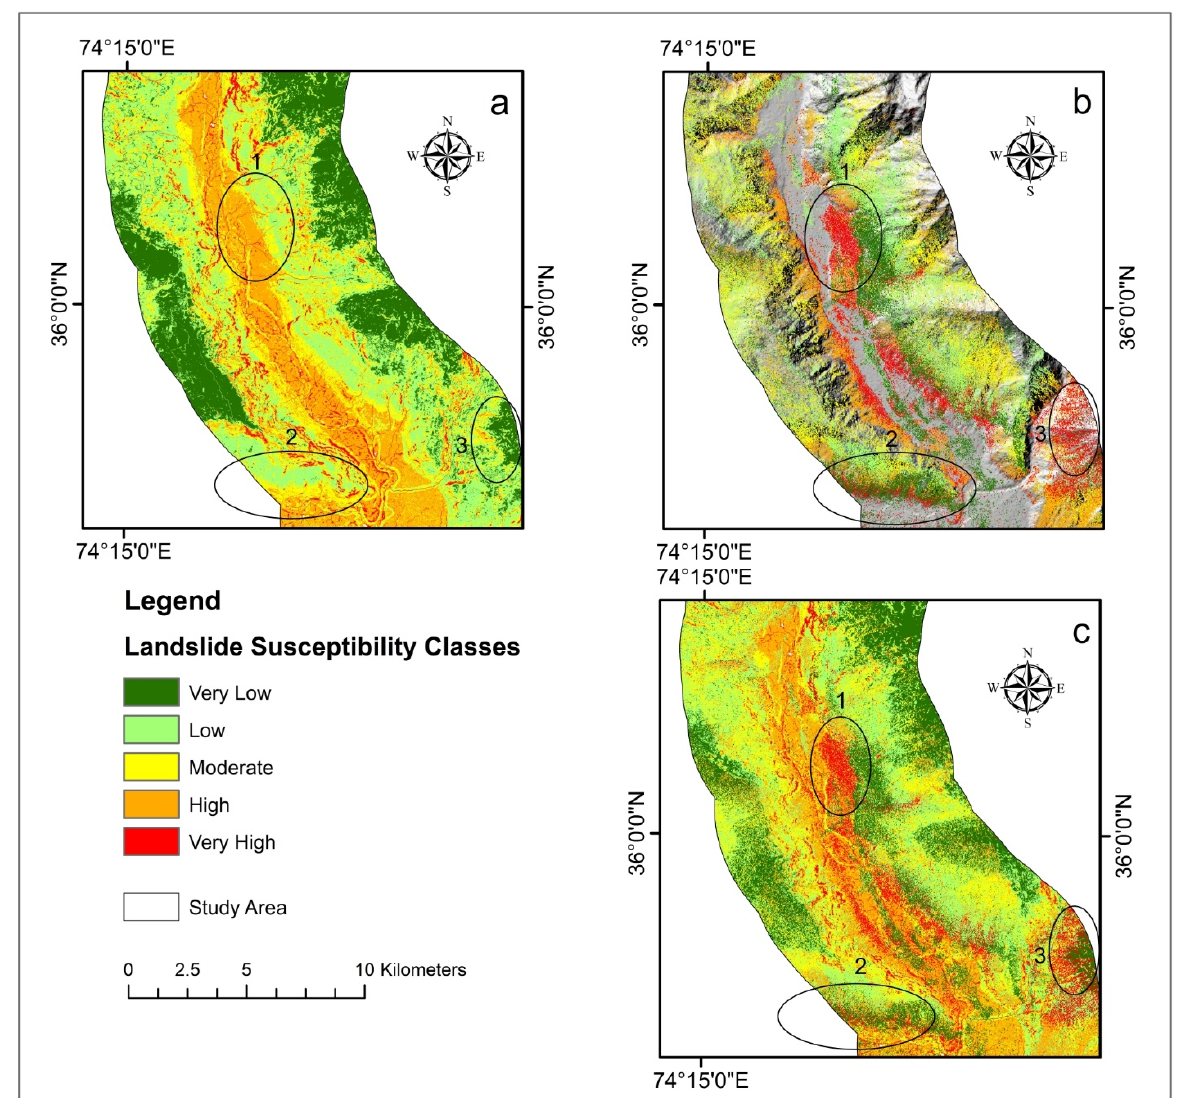
Figure 14. Results of landslide susceptibility Gilgit area. ( a ) LSM results were obtained using the XGBoost model. ( b ) PS ‐ InSAR ‐ based landslide deformation velocity (Vslope) map. ( c ) Improved landslide susceptibility map results.